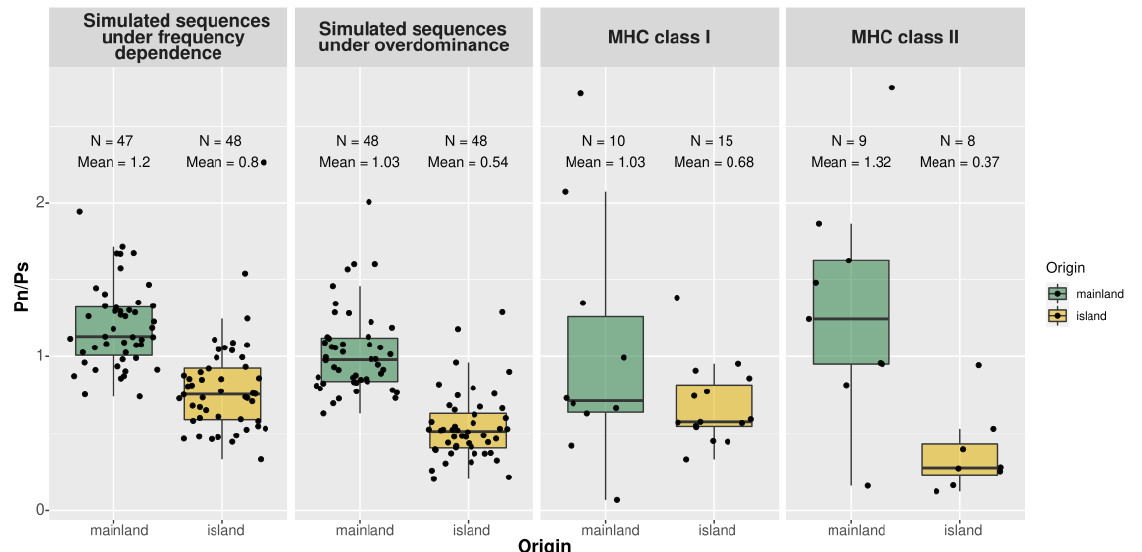
Figure 6: Boxplot of Pn/Ps according to species origin (mainland in green and insular in orange) for different gene categories under balancing selection. The number of species (N), and the mean Pn/Ps are shown for each modality. The control groups correspond to the results obtained from simulated sequence via SLiM (see Methods and Supplementary Methods Simulation of control genes under balancing selection).